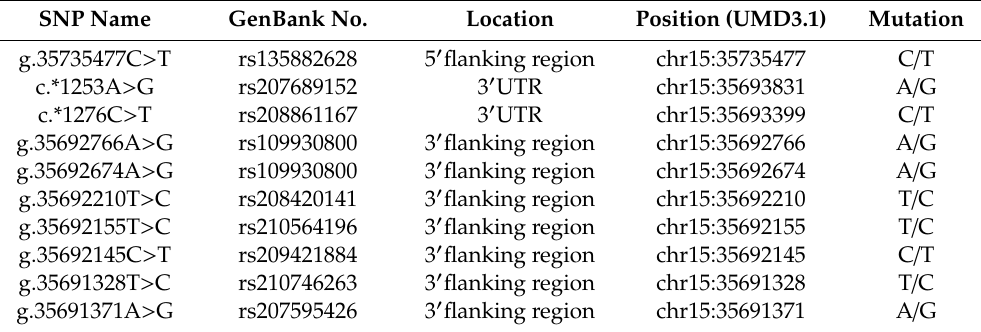
Table 1. Details about the identified SNPs of